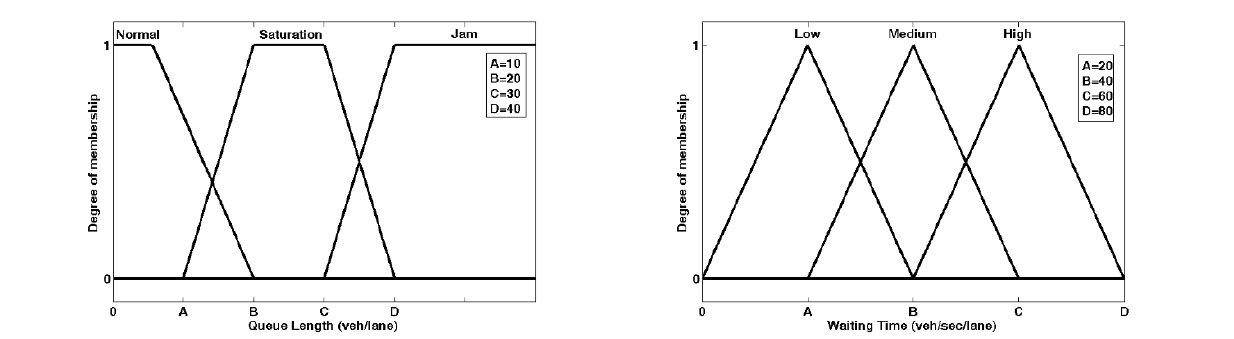
Figure 4. Fuzzy membership functions for LQRS